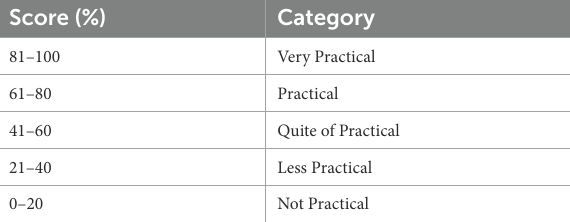
TABLE 2 Product development practical